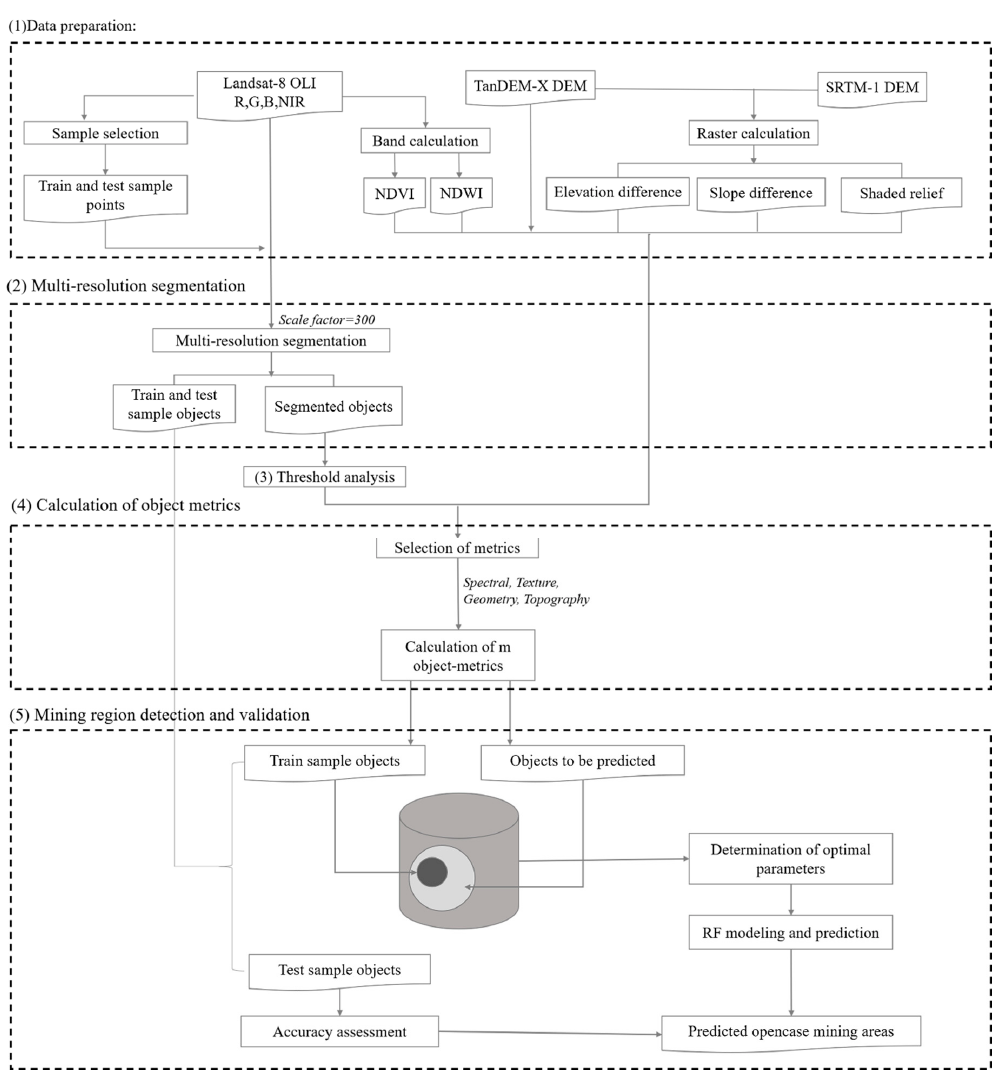
Figure 2. Workflow of the proposed method for detecting large-scale mining-ruined land by object-based image analysis (OBIA) and RF. The process includes data preparation, multiresolution image segmentation (MRIS), threshold analysis, object metrics calculation, and mine detection and